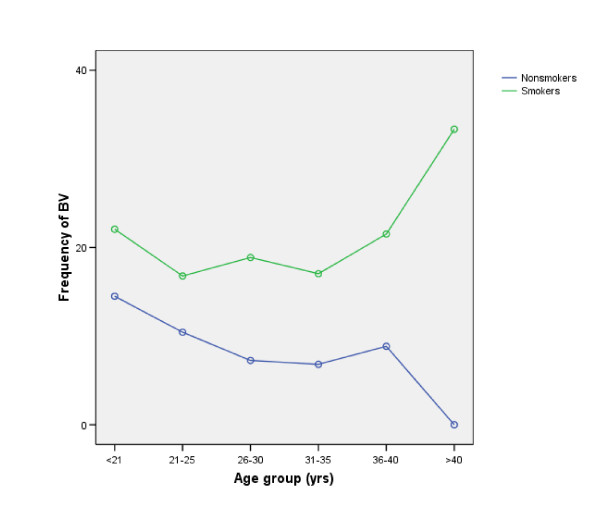
There is a significant declining frequency of BV with increasingage among nonsmokers. (OR for each age group are 0.83 (95% CI 0.75–0.90) but among smokers, the OR are 1.03 (95% CI 0.89–1.20). Women >40 yrs. of age who are smokers have a high percentage of BV, but this age group has a small population (of 9 women, only were 3 smokers).